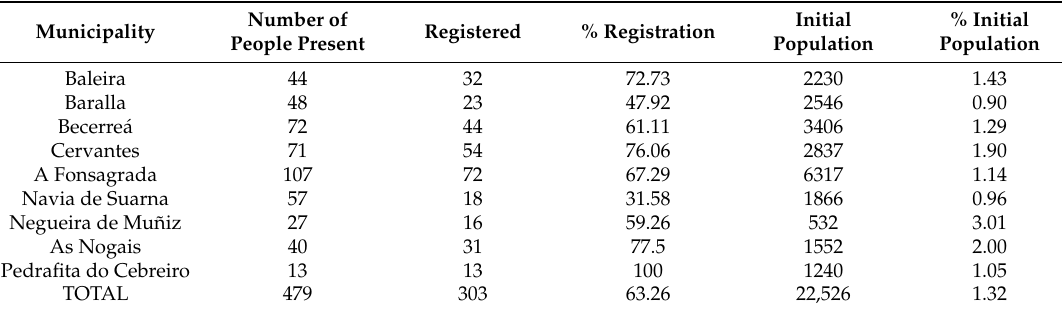
Table 6. Registration figures in the participative process by